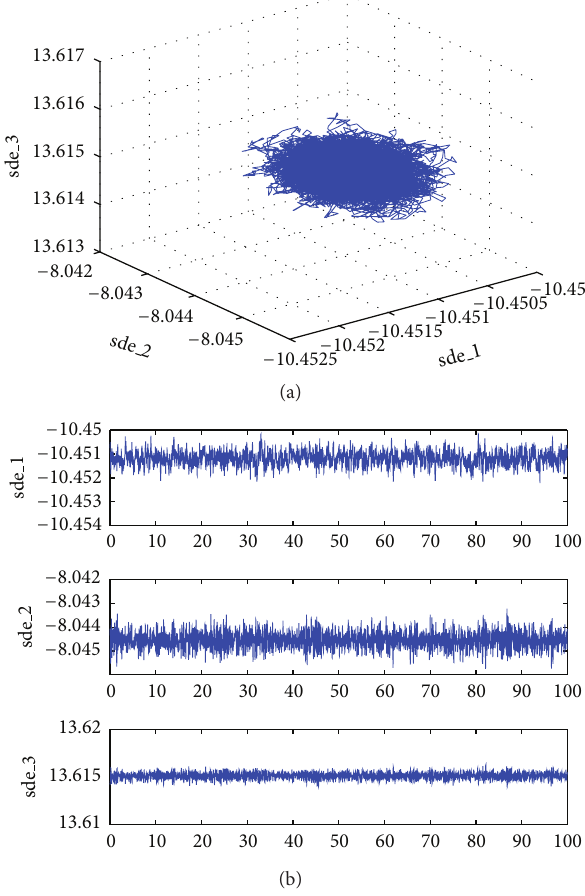
Figure 5: The behavior similar with the R¨ossler system (intensity of the noise 𝑢 𝑖𝑖 = 0.5 , 𝑢 𝑖𝑗,𝑖 ̸=𝑗 = 0 , 𝑖,𝑗 = 1, 2, 3 ).